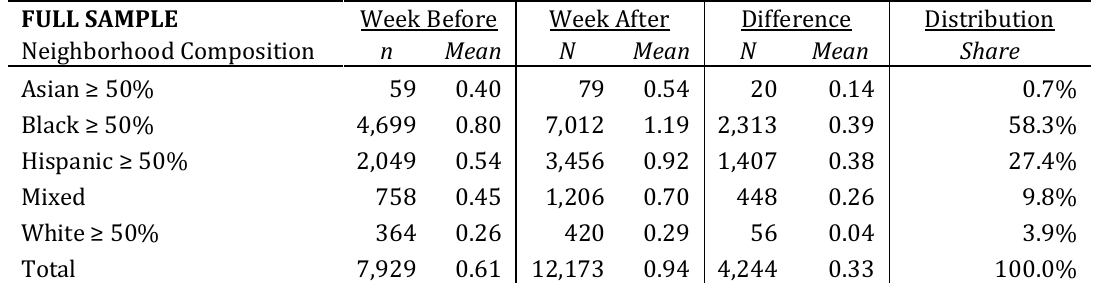
Table 1. Descriptive Statistics of SQF in Block Groups the Week before and after Homicide (2006–9) FULL